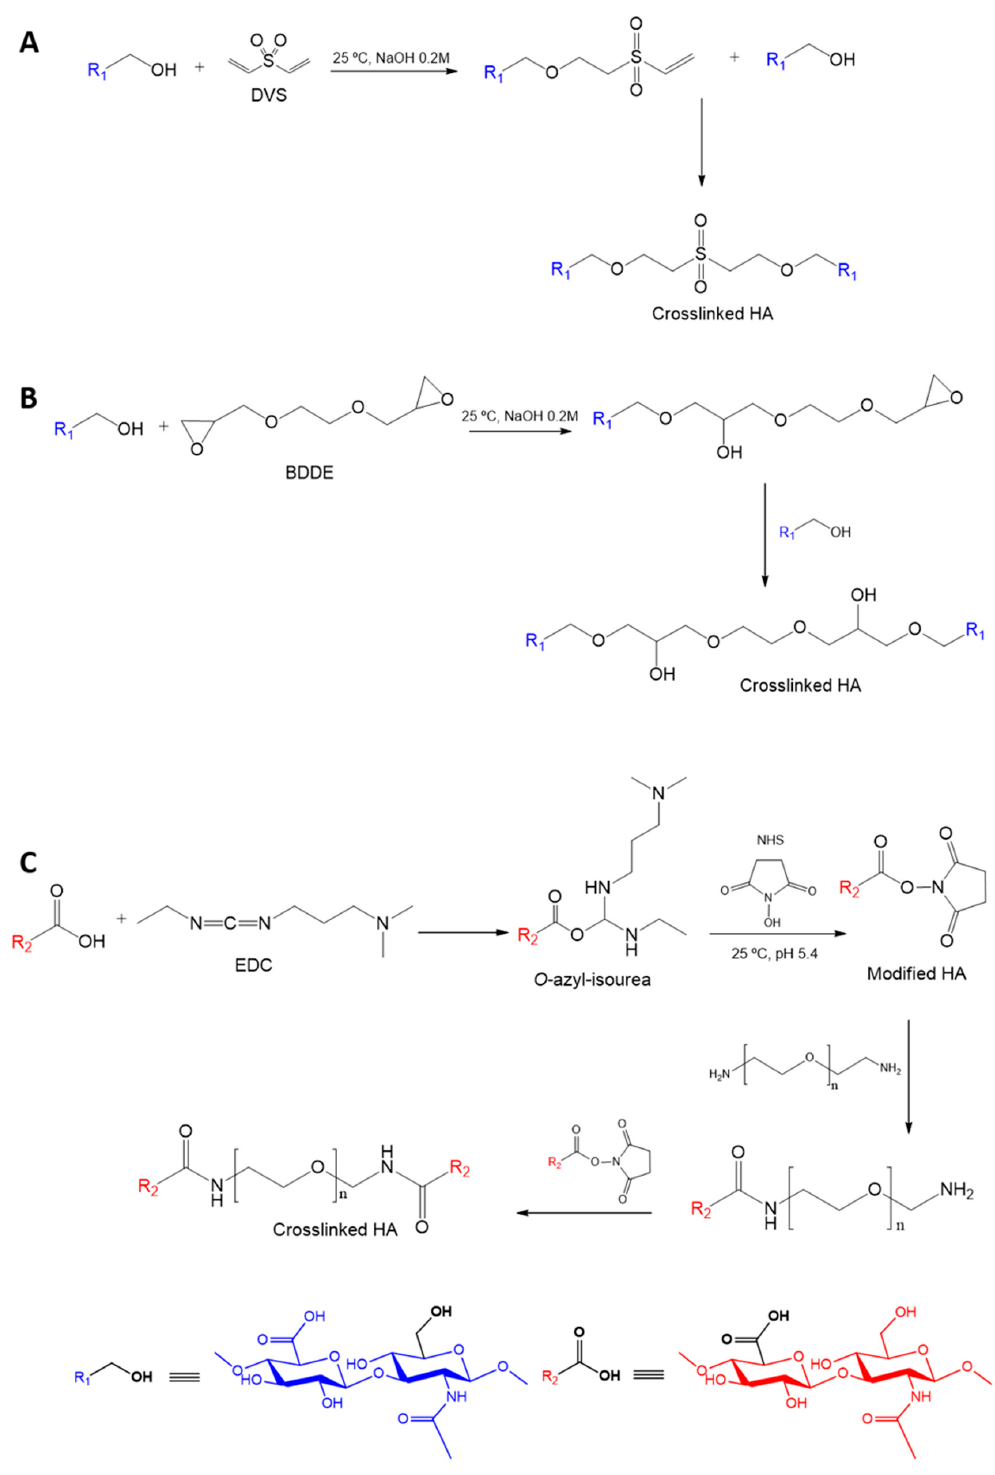
Figure 2. Schemes of crosslinking reactions of HA with ( A ) divinyl sulfone (DVS) ( B ) butanediol diglycidyl ether (BDDE), and ( C ) poly(ethylene glycol) bis(amine) (PEGBNH 2) followed in the preparation of covalently crosslinked HA nanogels.